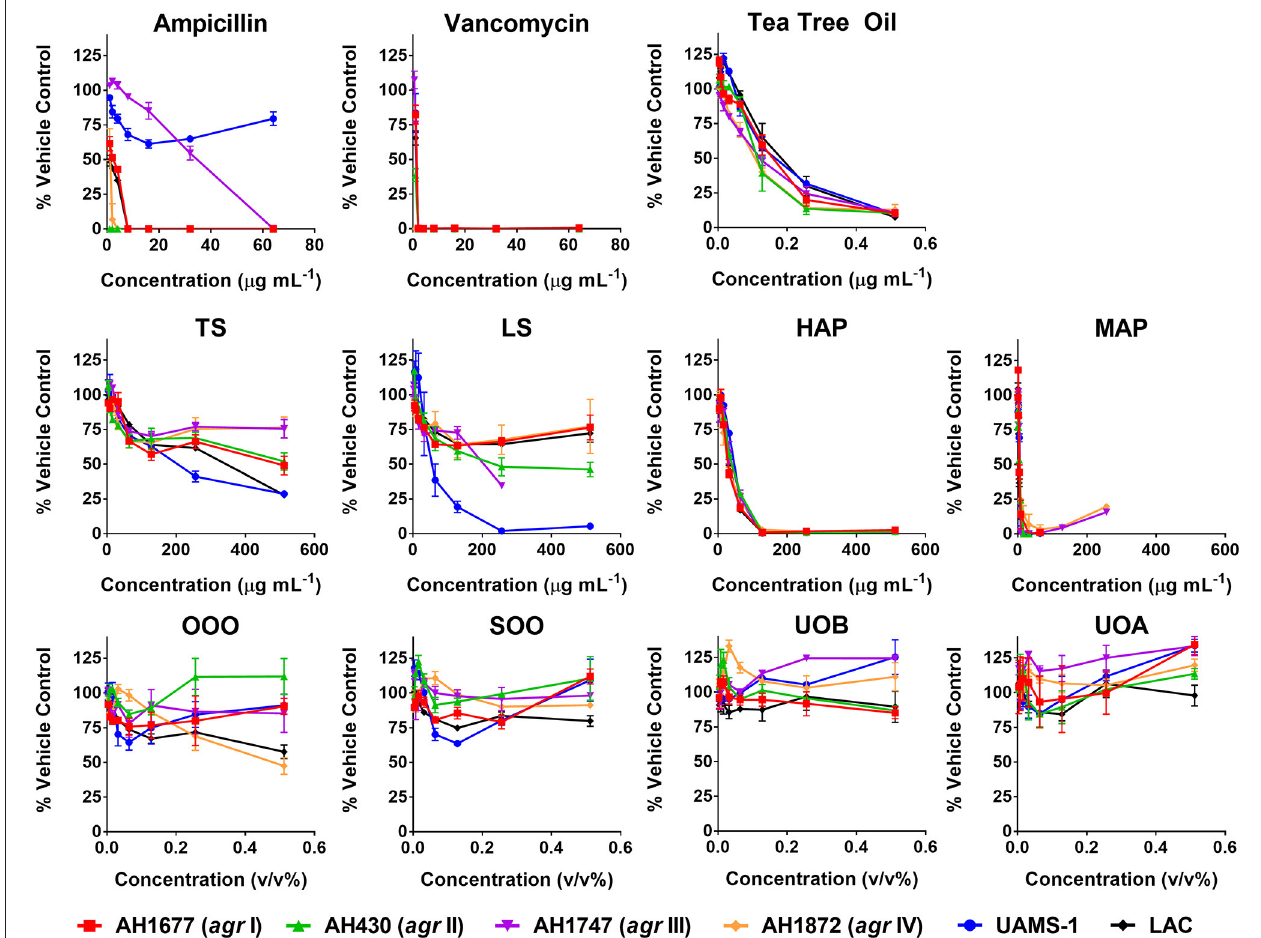
FIGURE 3 | Growth inhibitory activity of H. perforatum extracts against strains of S. aureus . Activity was detected by measure of optical density of wells (OD 600nm ) and is reported as percent of the vehicle control. Positive controls included antibiotics (ampicillin and vancomycin) and tea tree